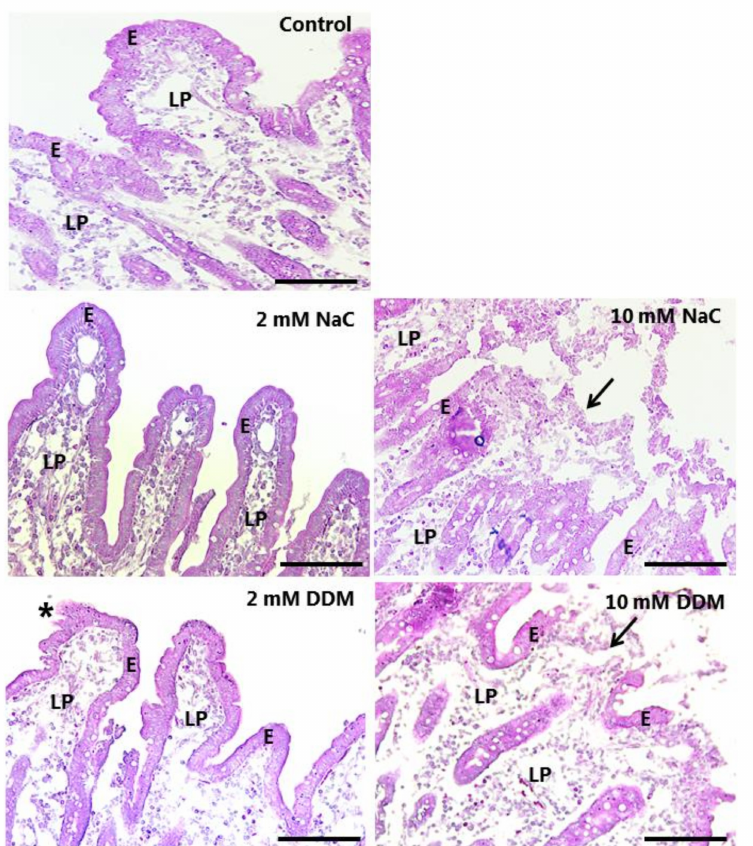
Figure 4. HE-stained sections of mucosal explants cultured for 1 h in the absence (control) or presence of 2 mM or 10 mM of NaC/DDM, as described in Methods. The villus organization and epithelium were generally well preserved at 2 mM of both surfactants, although foci of exfoliation was occasionally observed (asterisk). At 10 mM, both NaC and DDM caused extensive denudation, particularly near the tips of the villi (arrows), whereas the epithelium along the sides of the villi and in the crypts were generally better preserved. Enterocytes (E) and lamina propria (LP) are indicated. Bars: 100 µ